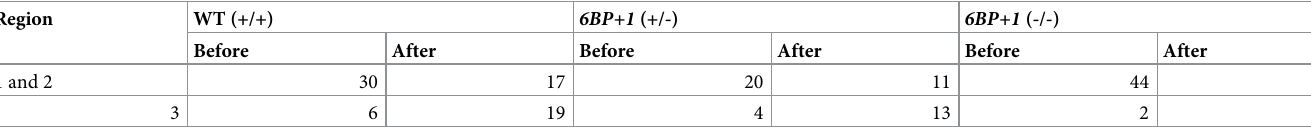
Larval zebrafish eyes track rotating patterns, and then snap back to reset [21]. This optokinetic response (OKR) is an obligatory visual reflex among vertebrates. The question is the role of red cones in this reflex. In Fig 13 eye movements are counted for colored rotating windmills presented on a laptop monitor for one minute. Larvae with mutant 6BP+1 tr β 2 homozygous (-/-) alleles, WT (+/+), or heterozygous mutant alleles (+/-) were shown white/black, red/blue, Table 3. OMR larval distributions before and after red/black stimulus. Region WT (+/+) 6BP+1 (+/-) 6BP+1 (-/-) Before After Before After Before After 1 and 2 30 17 20 11 44 43 3 6 19 4 13 2 3 Distribution of larvae in culture-plate regions before and after stimulation with red/black drifting gratings.